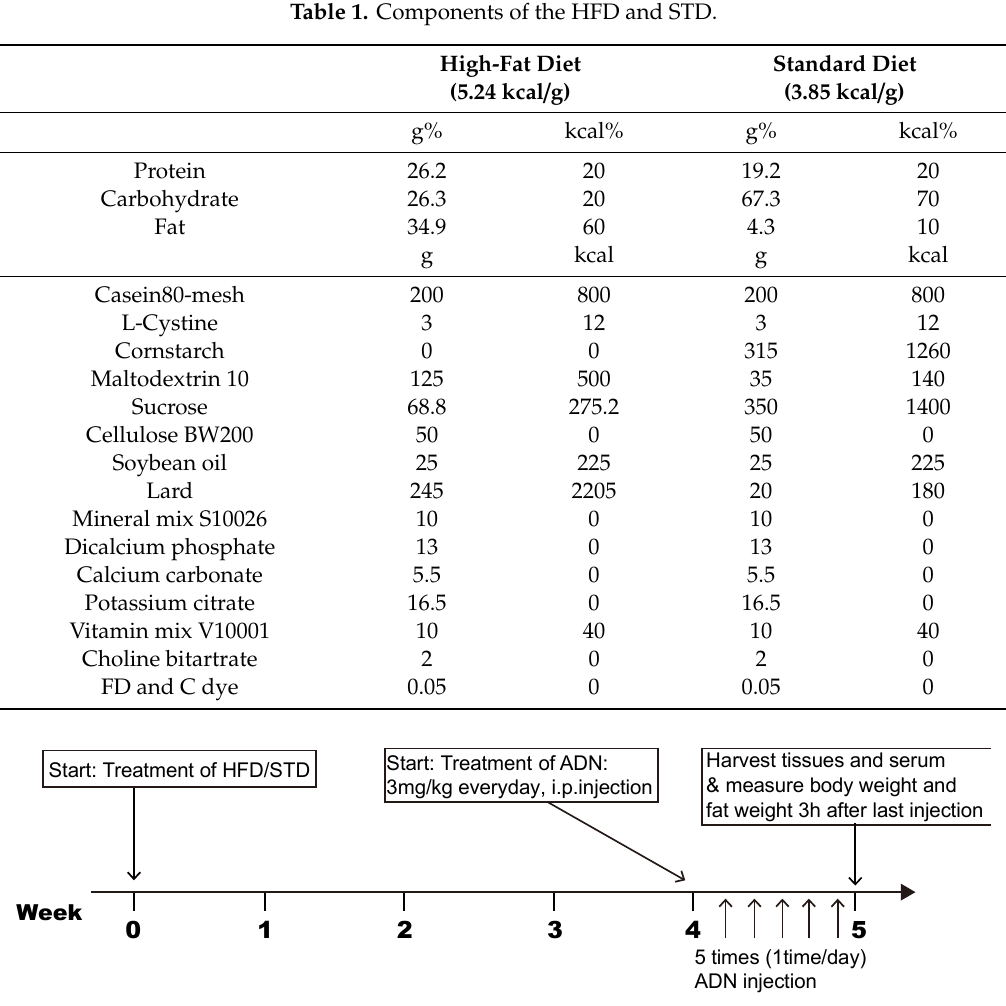
Figure 5. Flowchart showing the experimental procedure. Arrows indicate the start of treatment, sample preparation and analysis.